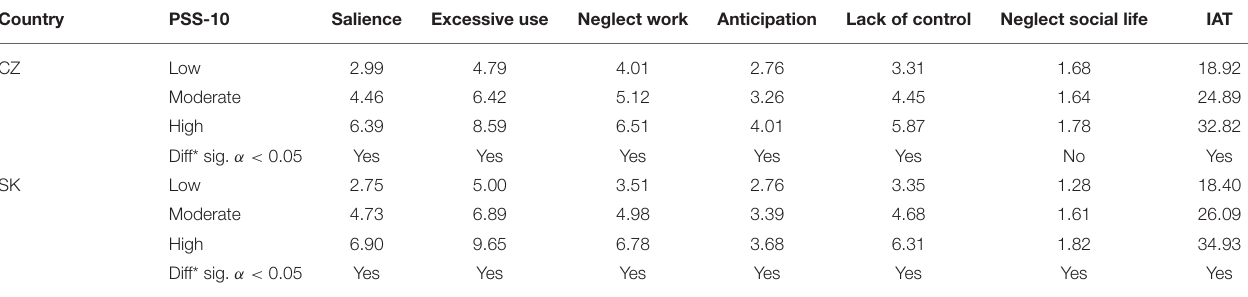
TABLE 10 | Mean values of the IAT and its subscales in the classification by stress level. Country PSS-10 Salience Excessive use Neglect work Anticipation Lack of control Neglect social life IAT CZ